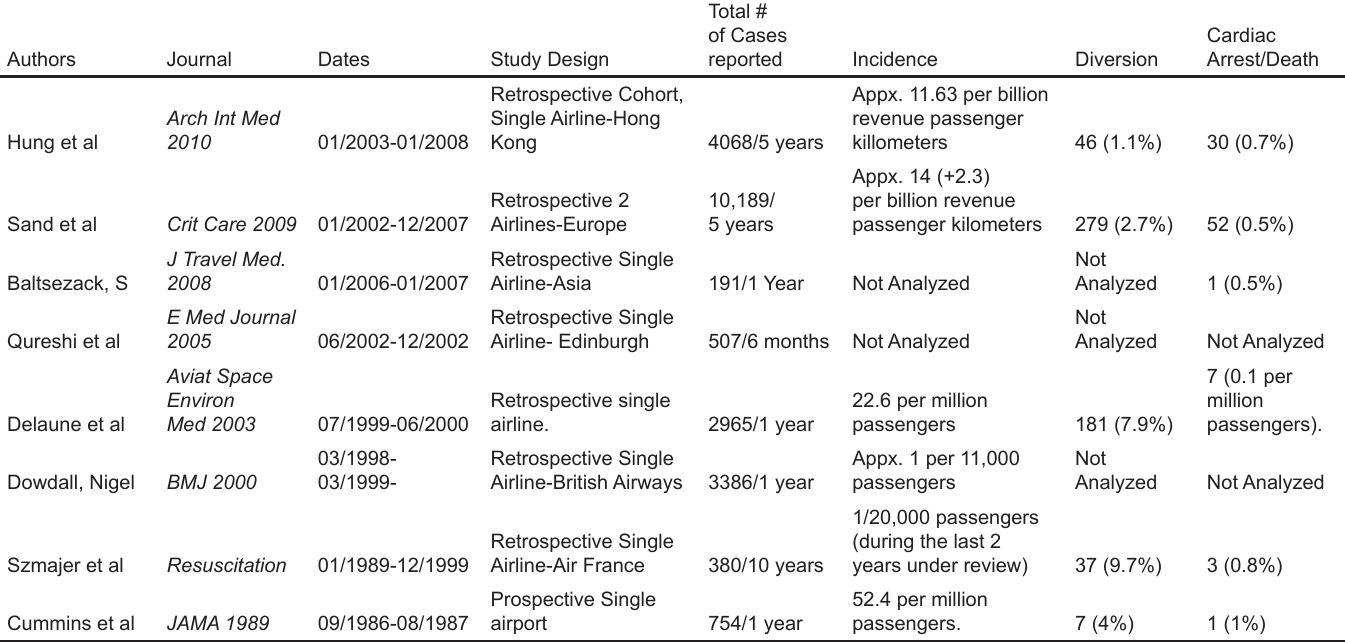
Table 1 . Study characteristics and incidence of in-flight medical